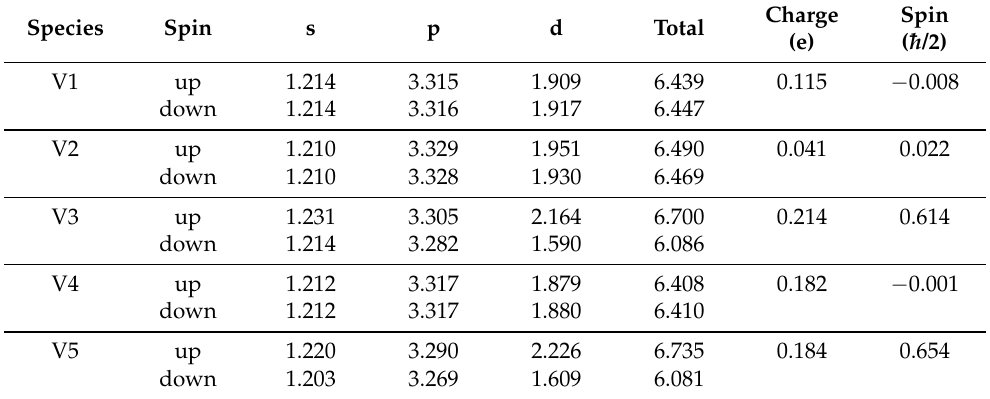
Table A4. Atomic populations (Mulliken) for mq-GOpt As 2 S 3 :V.